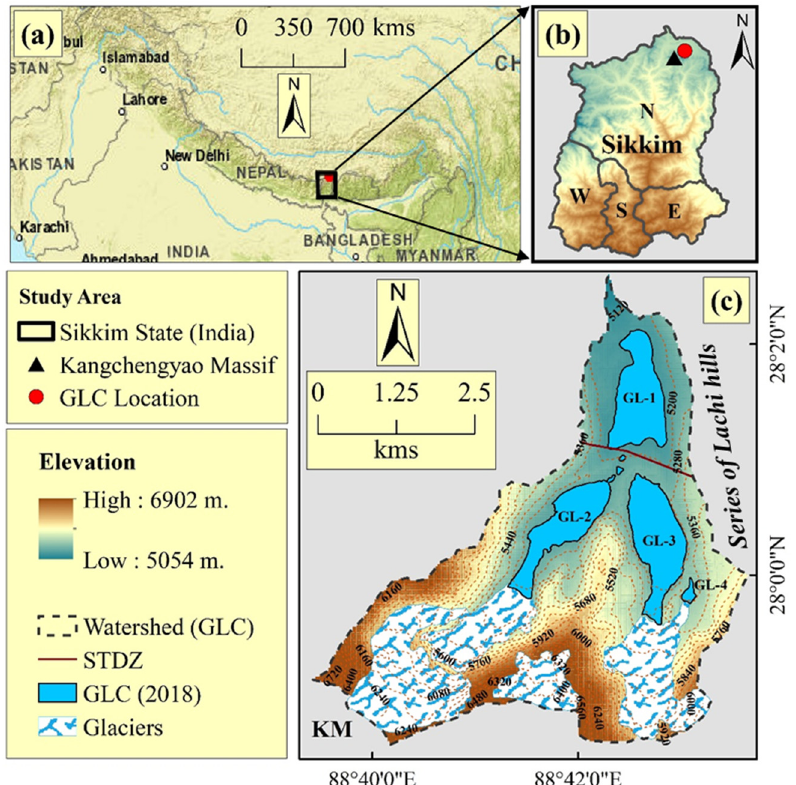
Figure 1. Location of the study area: ( a ) Topographic map of Indian sub-continent showing the study site (identified in red circle) in Sikkim (inset in a dark black box), a part of Eastern Himalayas. Base map: World Shaded Relief map; ( b ) Enlarged location of the Gurudongmar lake complex (GLC) is shown within the district boundary of Sikkim state of India; ( c ) Extent of the GLC within the catchment extracted from Sentinel 2A MSI (2018) and SRTM DEM (2000). Note: KM, Kangchengyao massif; STDZ, South Tibetan Detachment Zone.